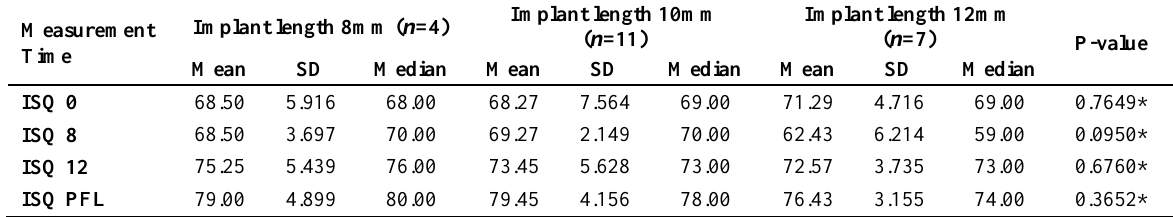
Table 5: The differences in implant stability in relation to DI length